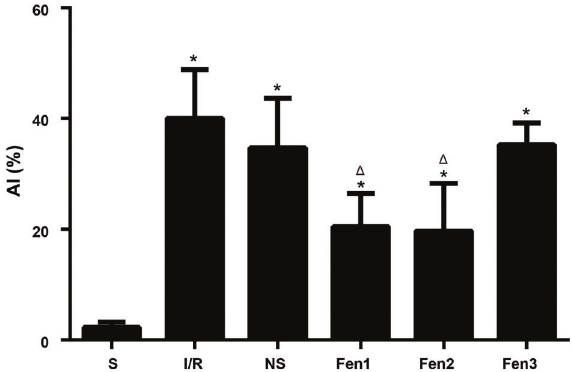
Figure 4. Comparison of the apoptosis index [AI (%)] in the sham operation (S) group, ischemia-reperfusion (I/R) group, normal saline (NS) group, and fentanyl (Fen)1 group (2 m g/kg), Fen2 group (4 m g/kg), and Fen3 group (6 m g/kg). *P o 0.05 compared to the S group; D P o 0.05 compared to the I/R group (one-way